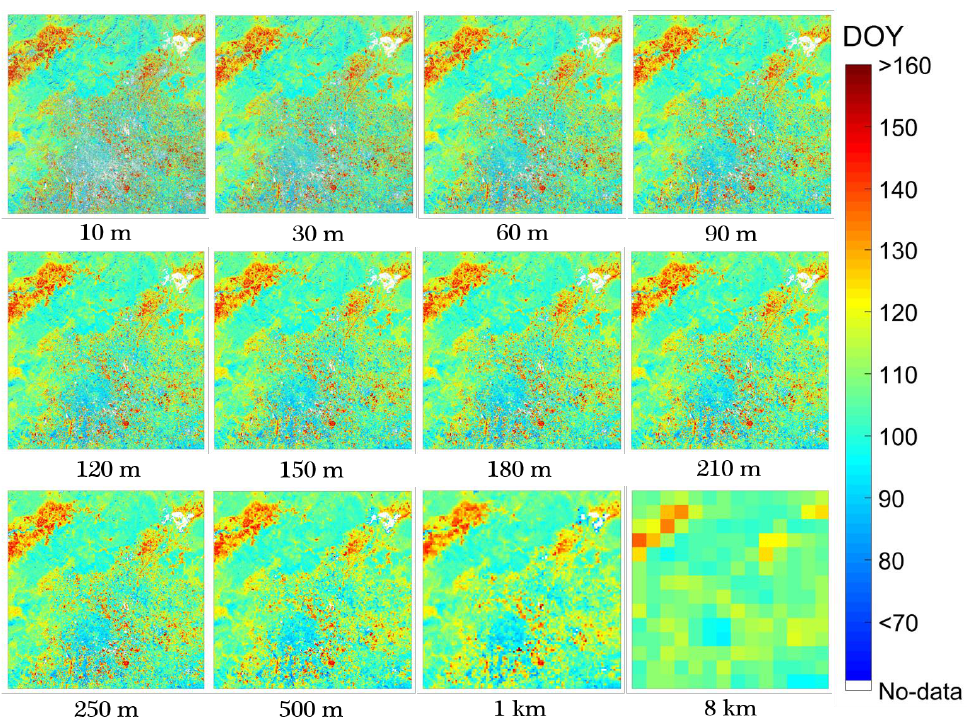
Figure 7. Vegetation spring phenology extracted by TIMESAT at different spatial resolutions.